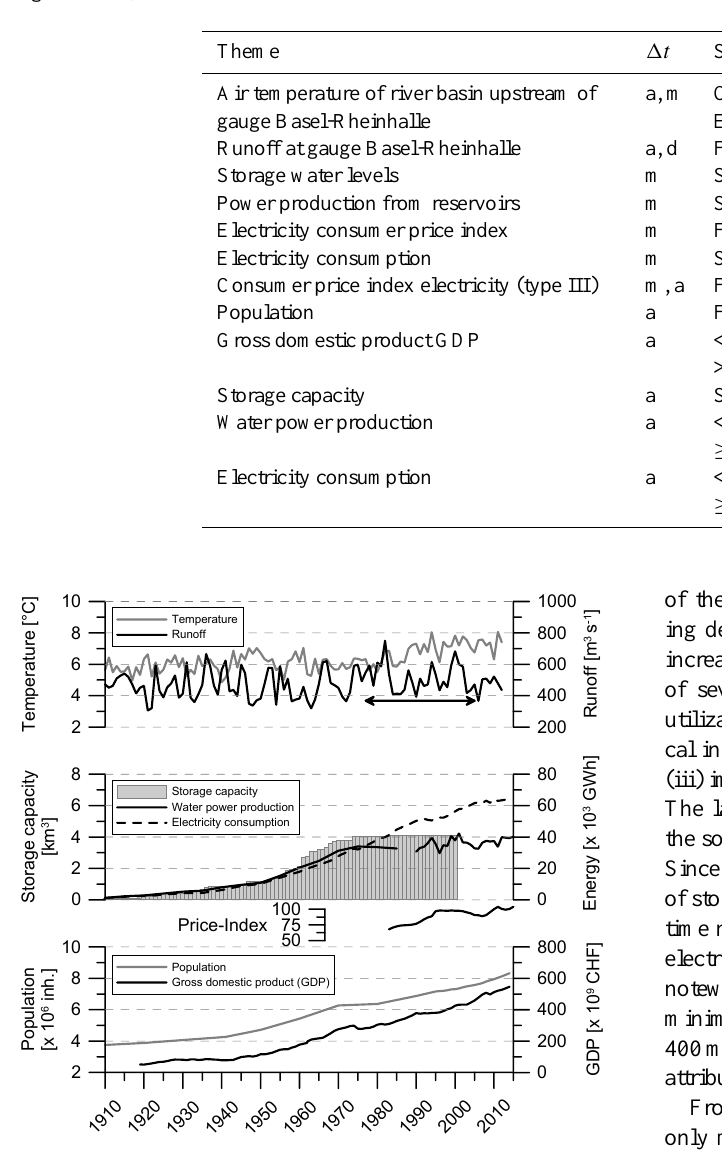
Table 1. Data used in case study “Water Power in Switzerland” ( (cid:49)t = temporal resolution, d = daily, m = monthly, a = annual; as plotted in Figs. 2 and 3).